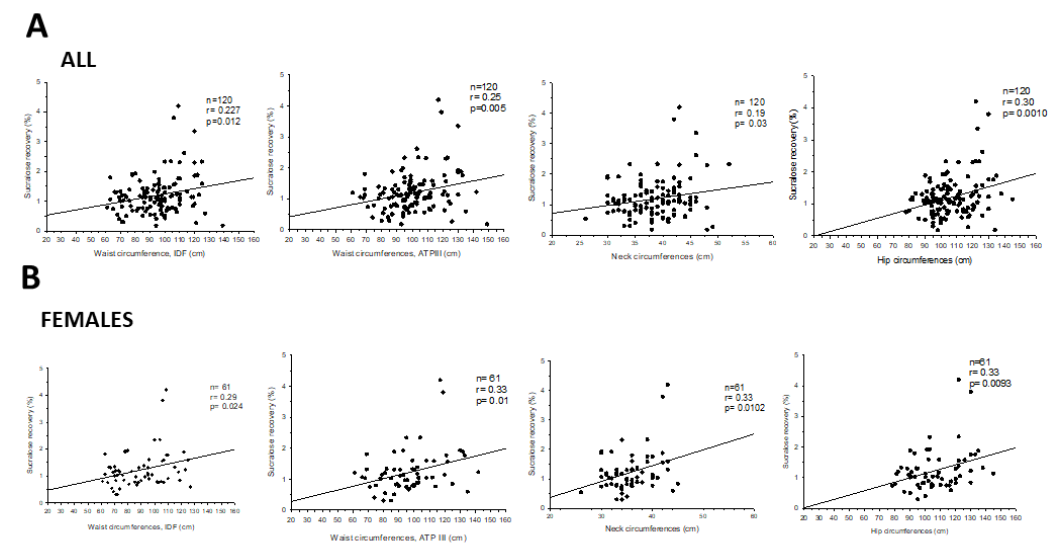
Figure6. Correlationbetweensucraloserecoveryandwaist, neck, andhipcircumferencesin: Allsubjects ( A ) and in females ( B ).